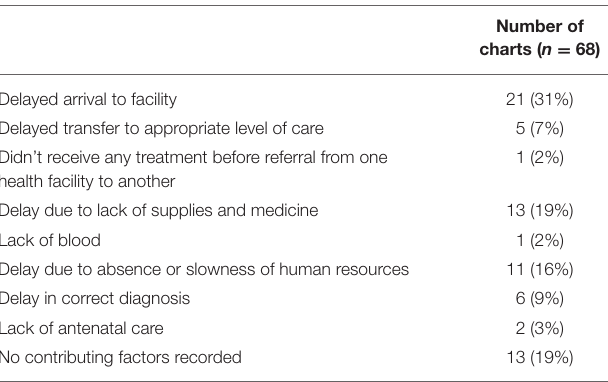
TABLE 3 | Recorded factors contributing to maternal death *